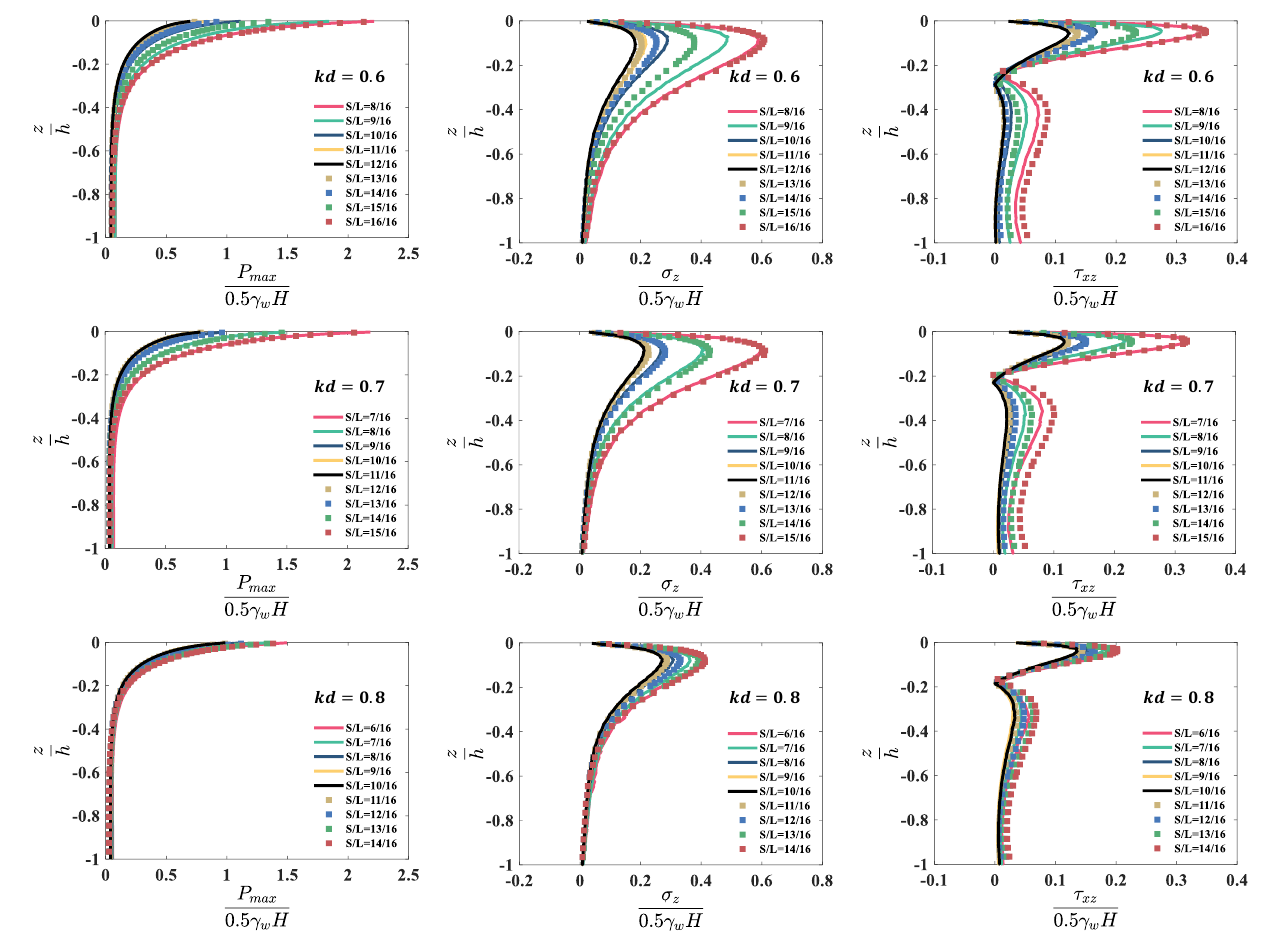
Figure 20. Vertical distributions of the wave−induced maximum pore pressure, the effective normal stress and shear stress at the toe of the vertical breakwater, in the case with 𝑚 = 3 .